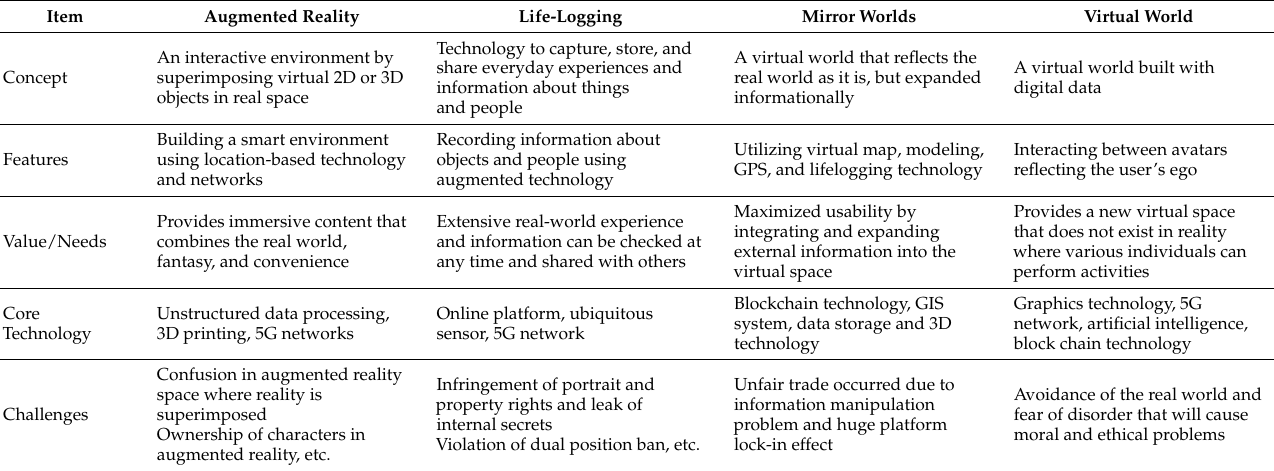
Table 2. Characteristics of four different metaverse service